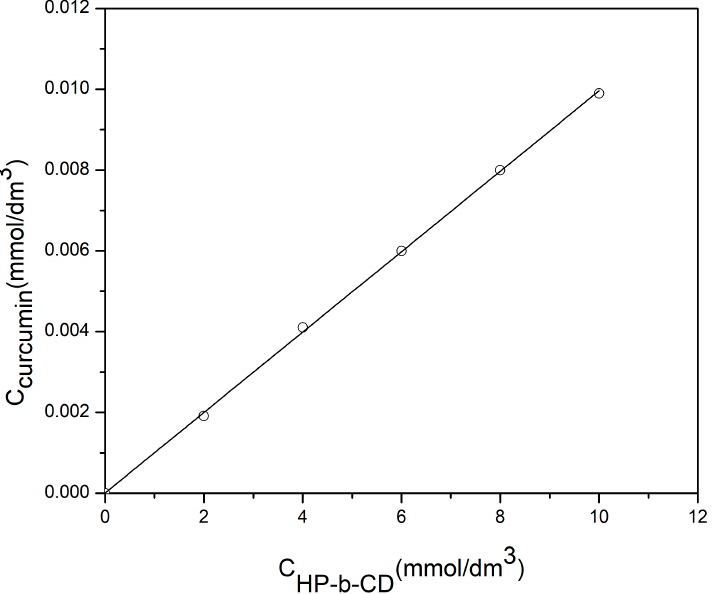
Figure 5. Phase solubility diagram of curcumin in the presence of 2-hydroxypropyl- β -cyclodextrin in water solution at 25 °C.